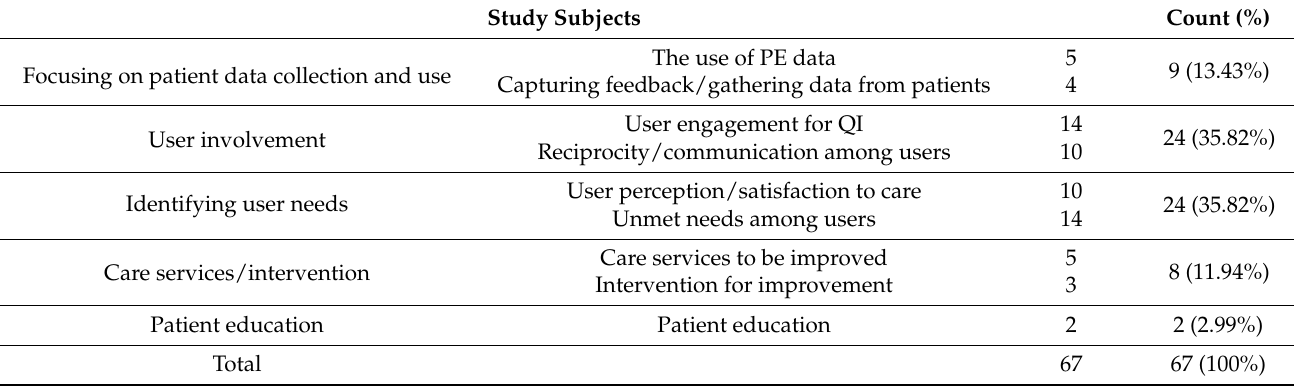
Table 2. Summary of study subjects.